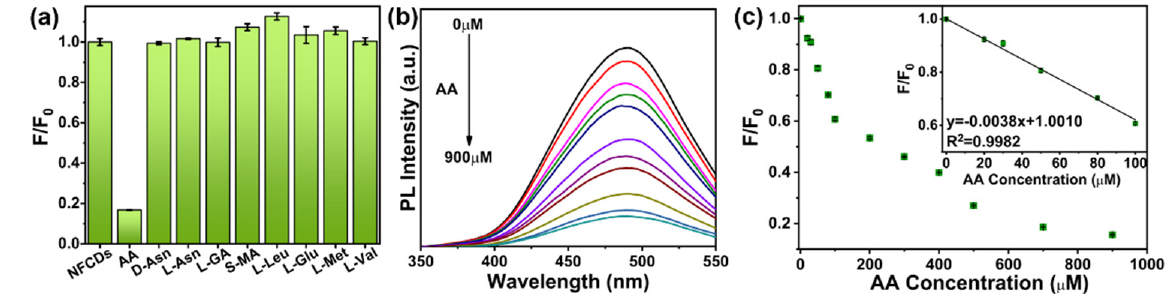
Figure 6. ( a ) The relative fluorescence intensity of NFCDs with the presence of different organic molecules. Error bars show standard deviations of repetitive experiments. ( b ) The PL spectra of NFCDs with various concentrations of AA, ranging from 0 to 900 µM. ( c ) The relative PL intensity (F/F 0 ) decay with various concentrations of AA: inset: linear relationship between quenched intensity with concentrations of AA, y = − 0.0038x + 1.0010, R 2 = 0.9982.